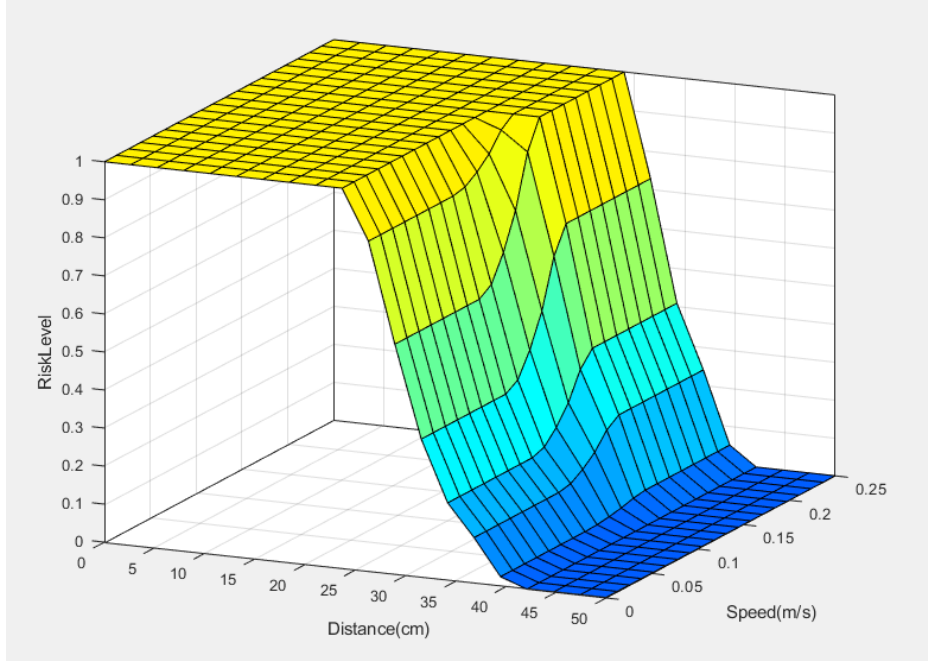
Figure 14. Decision surface for the Fuzzy Collision Risk with two inputs: Distance and Speed